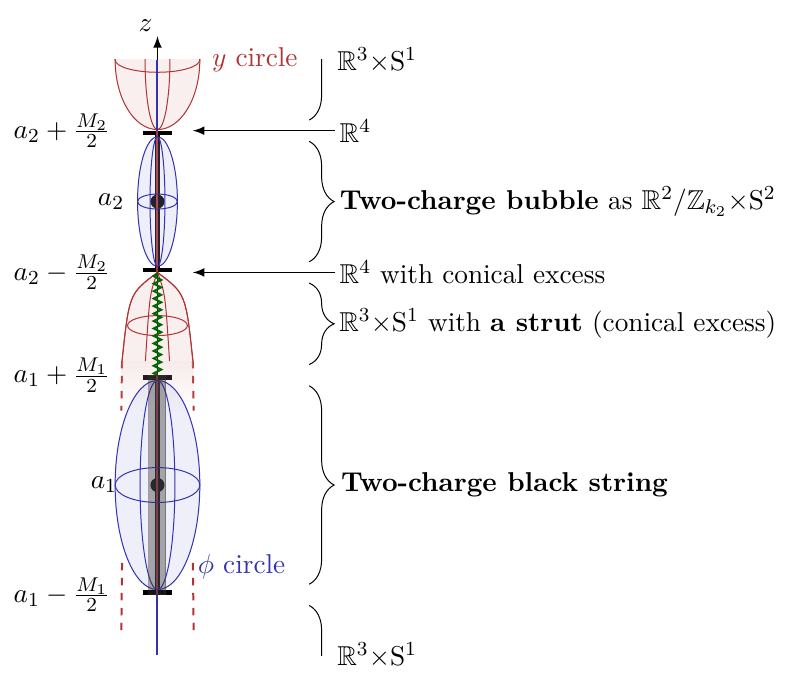
Figure 6 . Illustration of the topology on the z -axis for a solution with one black string and one topological star. The behavior of the y -circle is depicted in red: it shrinks at the bubble rod and have a finite size otherwise. The φ circle is in blue: it shrinks out of the rods and has a finite size at the rods. The magnetic and electric fluxes are wrapped on the blue bubbles at the